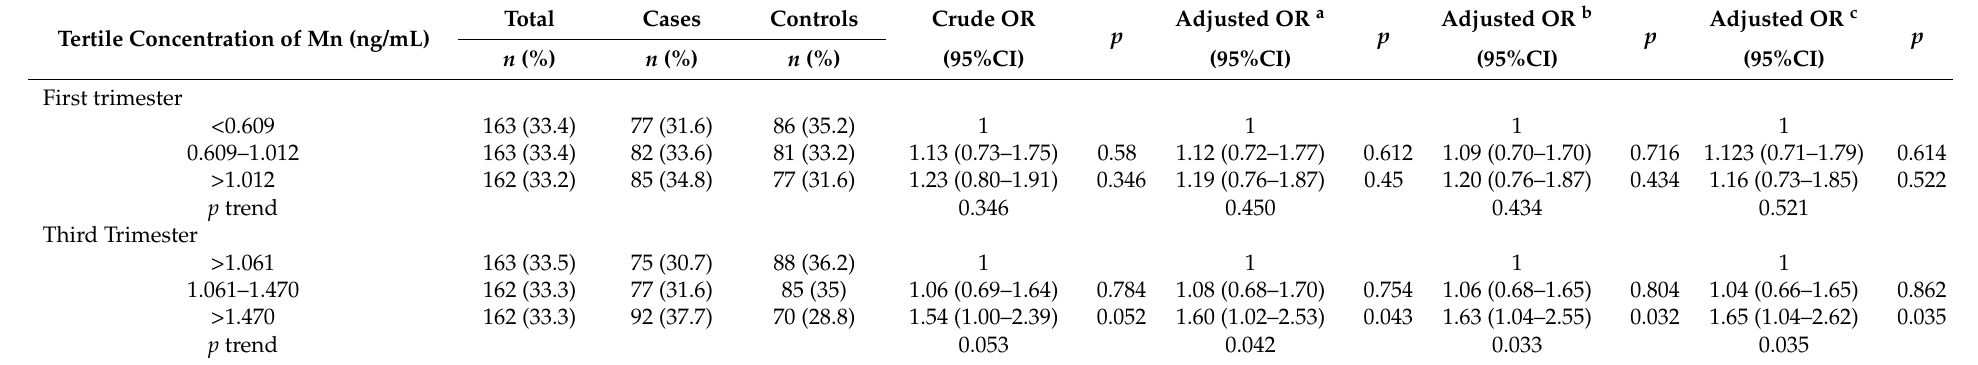
Table 3. Association of maternal plasma Mn levels with